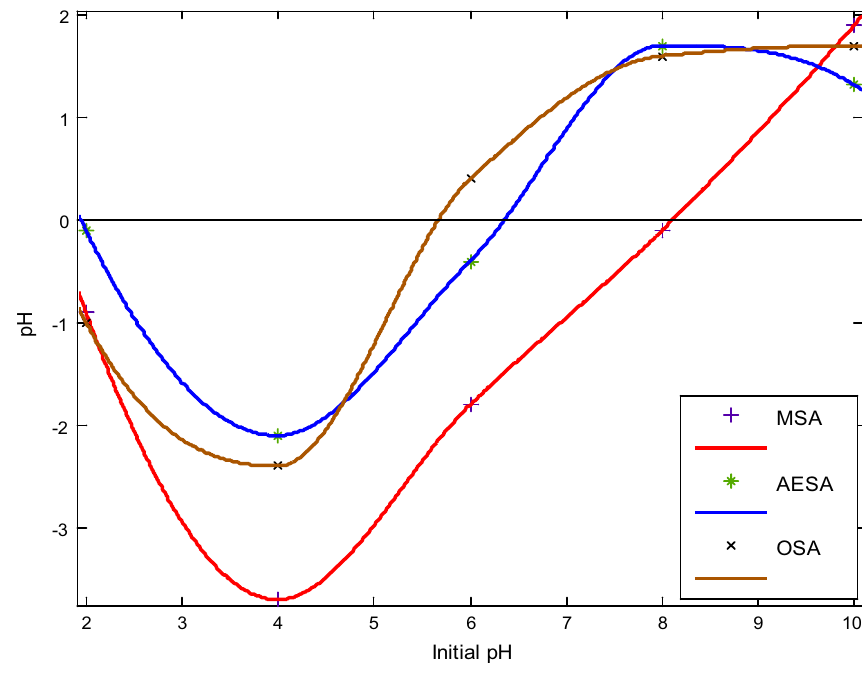
Fig. 1 Point of zero charge for acid-treated